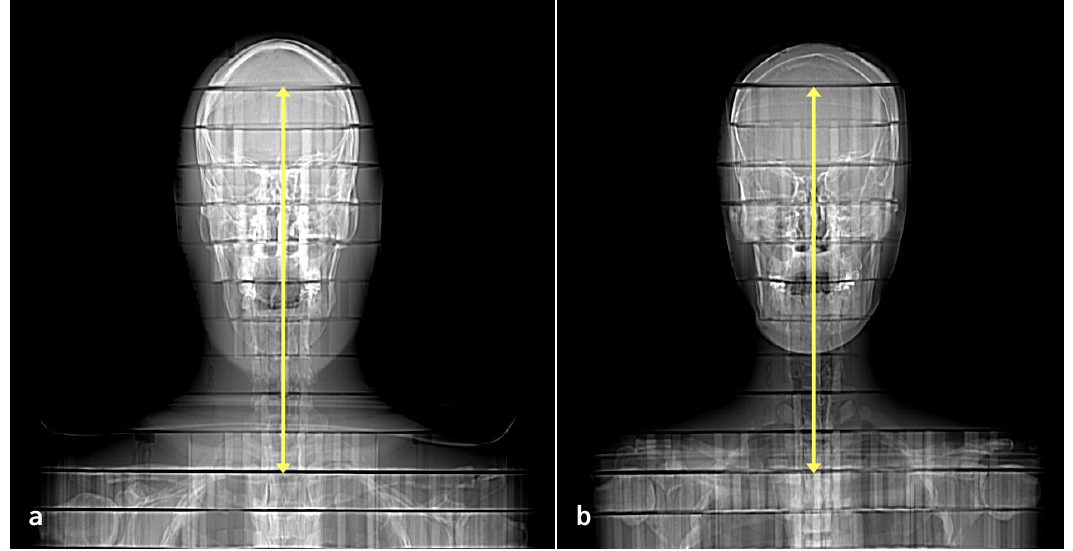
Figure 1. Scout of male (a) and female (b) anthropomorphic